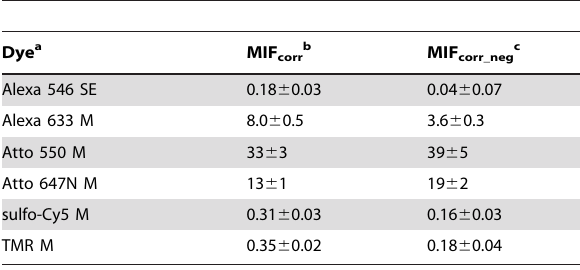
Table 2. Comparison of MIF Values Measured Against Zwitterionic 100% Egg PC Vesicles (MIF corr ) and Against Negatively Charged 90% Egg PC/10% DOPS